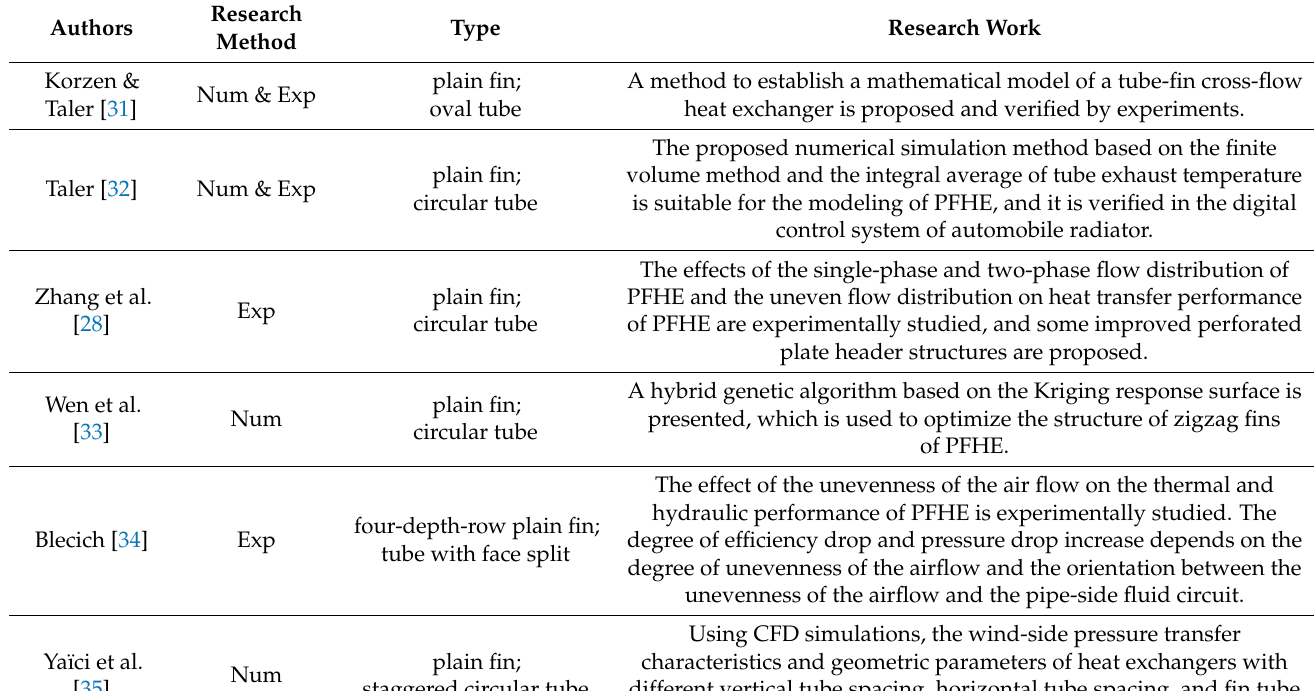
Table 1. Summary of research work on plate-fin heat exchangers in the past five